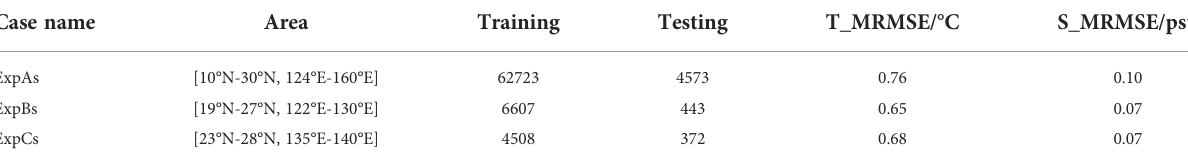
TABLE 1 The number of pro fi les being used for training and validation and the measurement error in the assimilation